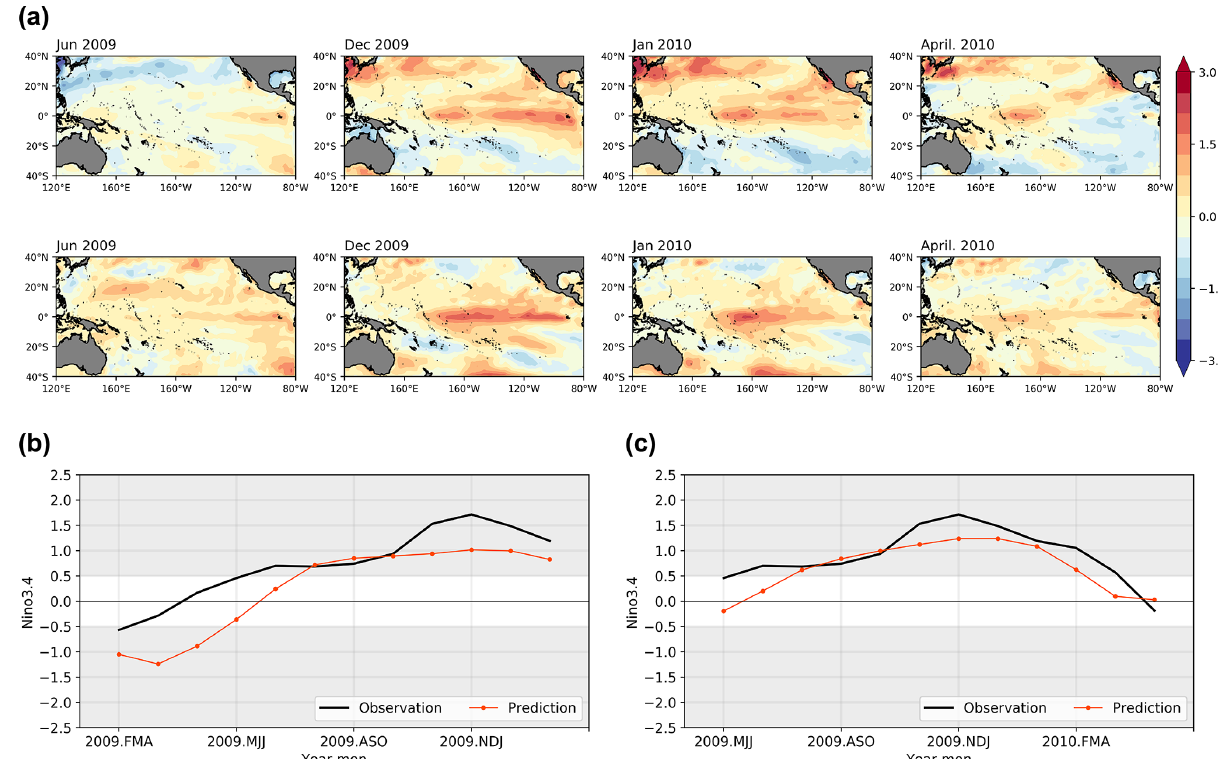
Figure 7. The SST anomalies patterns and index prediction results for 2009–2010 El Niño using ENSO-MC. (a) Spatial development of SST anomalies predicted (the first row) 1 year in advance compared with the real observations (the second row) for the onset, growth, mature and decay phases. (b) Niño 3.4 index time series forecast initiated in the FMA season using ENSO-MC (red line) and the observed Niño 3.4 index (black line). (c) Niño 3.4 index time series forecast initiated in the MJJ season using ENSO-MC (red line) and the observed Niño 3.4 index (black line). Table 2. Correlation skill (Corr) and root mean square error (RMSE) of lead times with different input sequence lengths. Lead